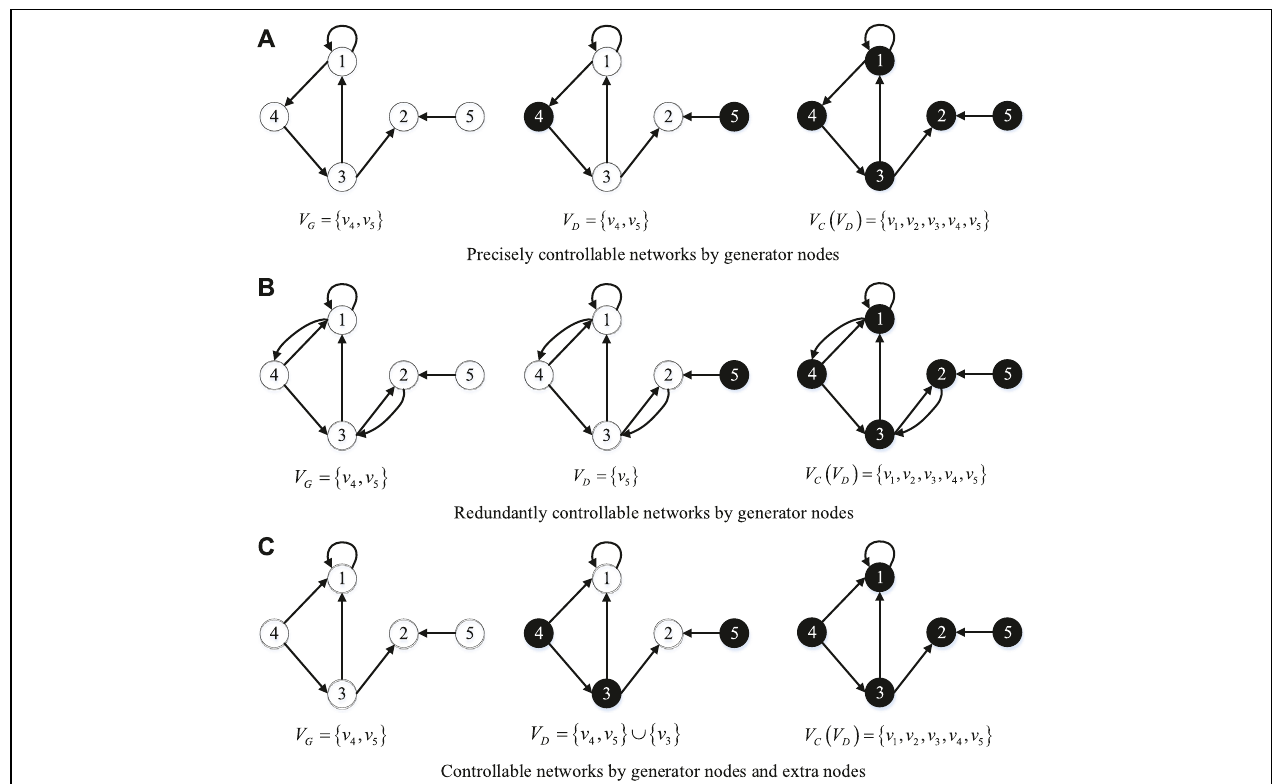
FIGURE 2 | Three kind of controllable networks by generator nodes. (A) Precisely controllable networks by generator nodes; (B) Redundantly controllable networks by generator nodes; (C) Controllable networks by generator nodes and extra nodes.